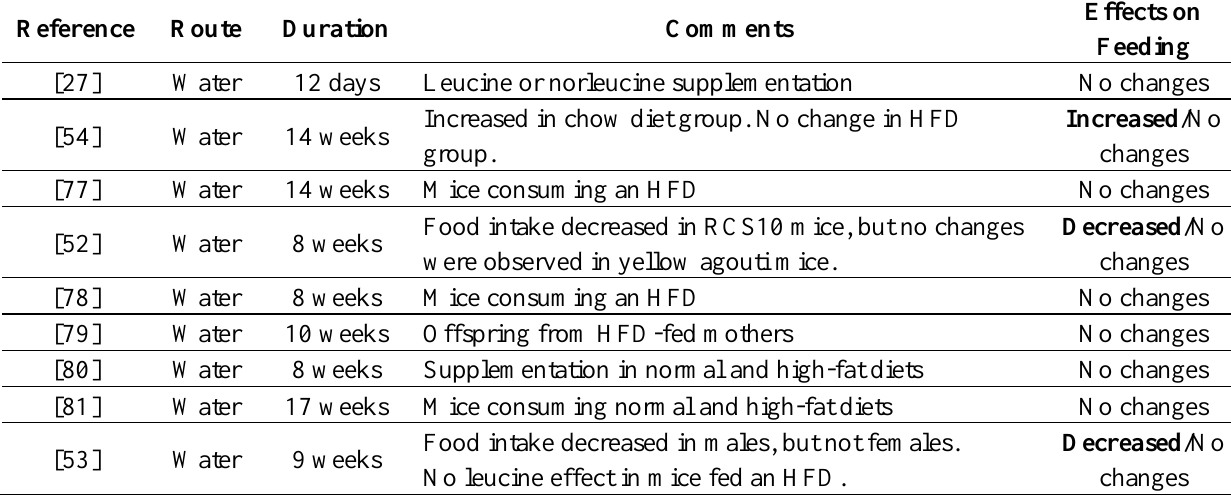
Table 3. Summary of the studies that investigated the effects of leucine supplementation in the drinking water or by other routes of